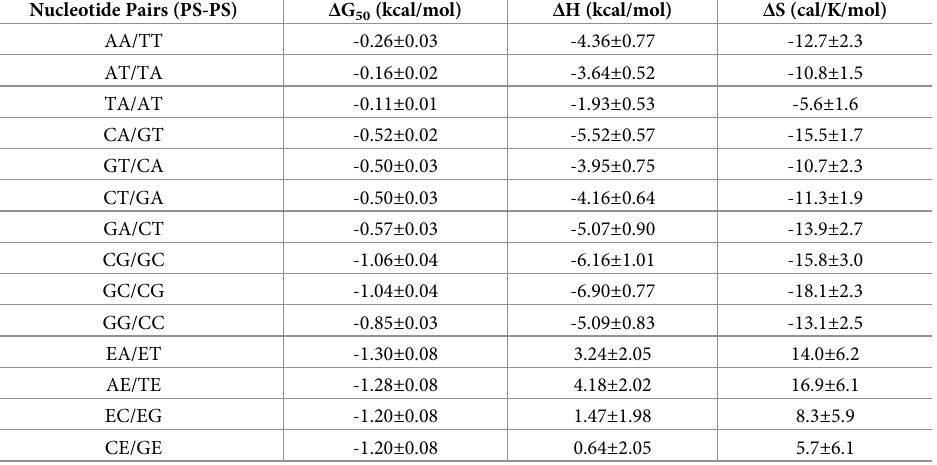
All reported values are adjusted to 1 M NaCl and 50˚C. All internal nucleotide parameters have PS linkages both